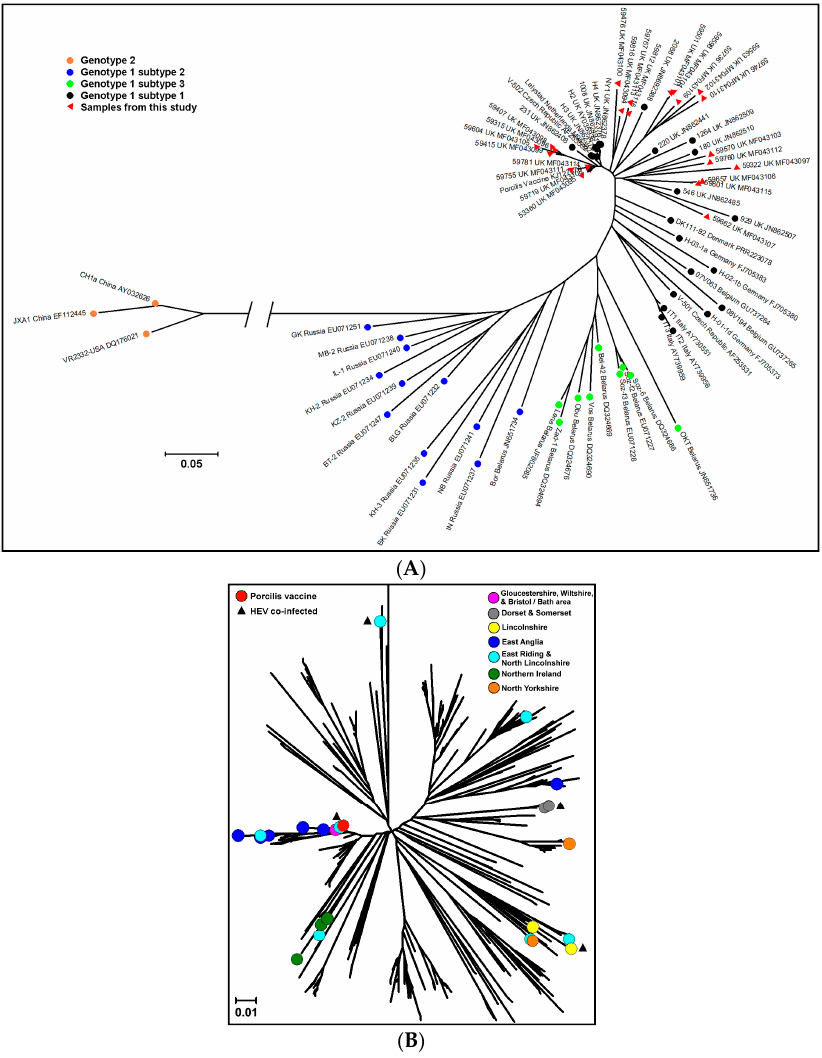
Figure 1. Diversity of porcine reproductive and respiratory syndrome virus (PRRSV) ORF5 sequences. Alignment of the sequences was performed with the ClustalW algorithm [18], and phylogenetic analyses (neighbour-joining method with bootstrap test) were conducted using MEGA software version 6 [19]. ( A ) Worldwide: The 23 ORF5 sequences obtained from the polymerase chain reaction (PCR)-positive samples (red triangles) are shown in the context of 48 worldwide reference ORF5 sequences from different genotypes and subtypes, and the modified-live vaccine sequence. The color of the markers indicates the genotype and subtype of the viruses. The scale bar represents five nucleotide change per 100; ( B ) United Kingdom (UK): The 23 ORF5 sequences obtained from the PCR-positive samples (colored circles) are shown in the context of 431 other UK ORF5 sequences dating from 1991 to 2014, and the modified-live vaccine sequence. The black triangles indicate samples that were also positive for hepatitis E virus by PCR. The color of the markers indicates their geographic origin. The scale bar represents 1 nucleotide change per 100.